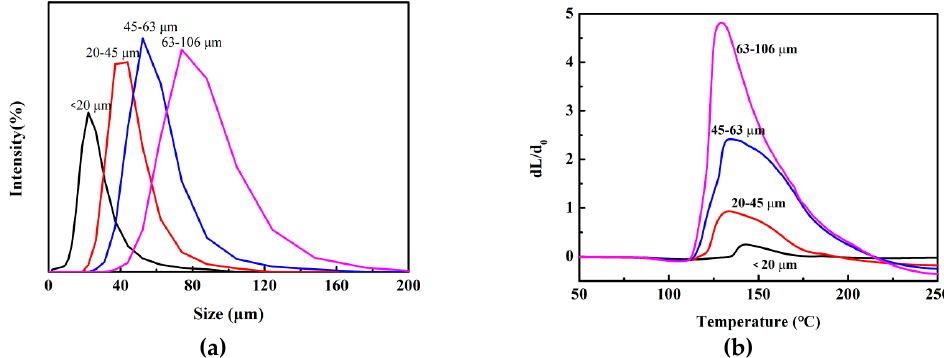
Figure 3. Performance analysis of TEMs with different particle sizes: ( a ) particle size distribution; ( b ) expansion performance.